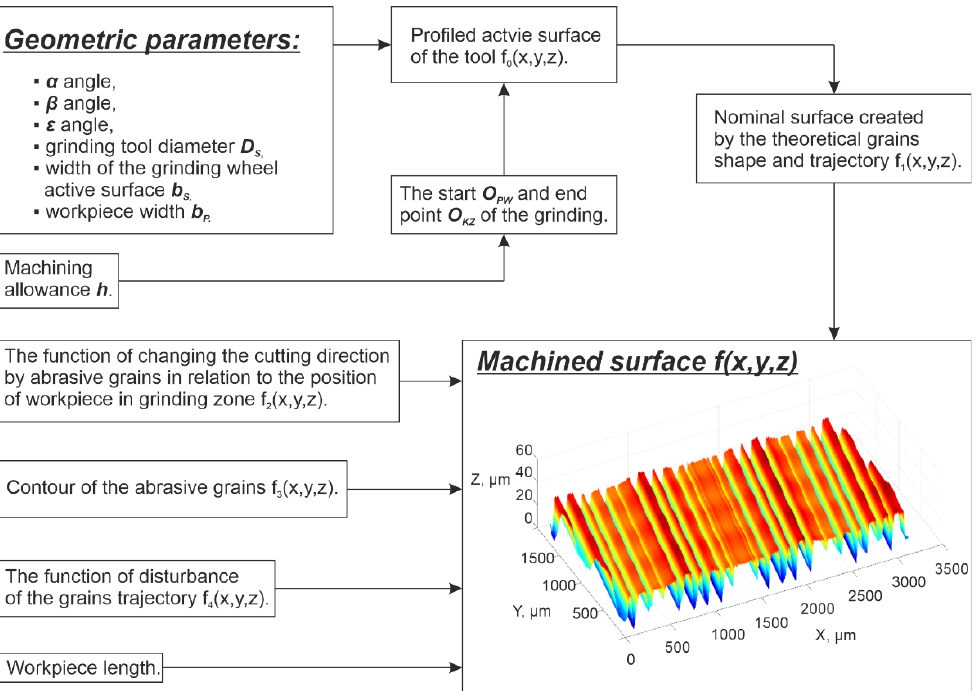
Figure 4. Methodology for generating areas of contact between conical or hyperboloidal tools and the workpiece surface.